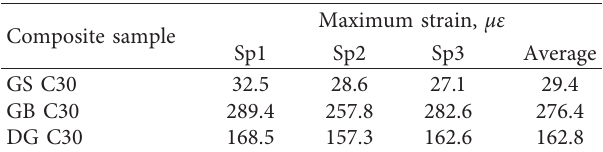
Figure 4: Relationship of the shearing stress over the relative displacement of the interface. Table 5: The maximum strain of the interface at failure for composite samples with different cement